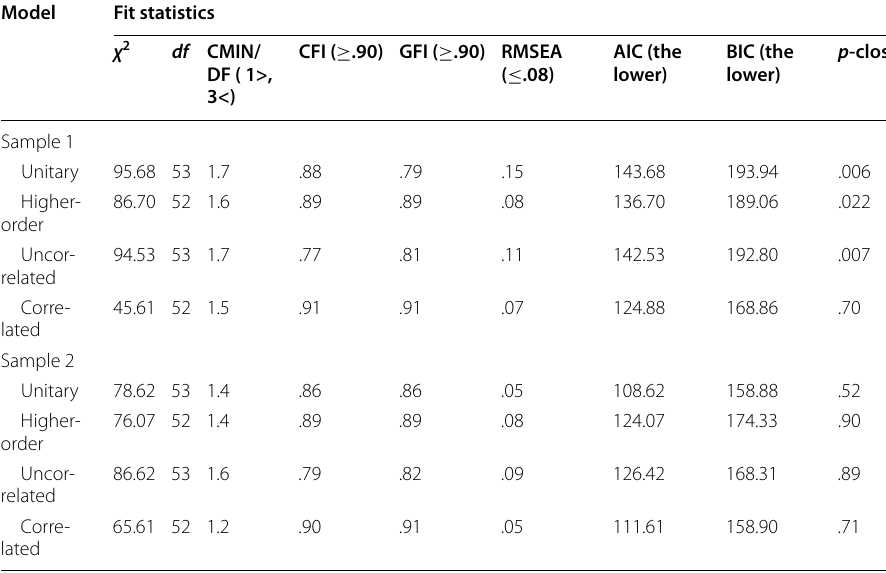
Table 3 Goodness-of-fit indices of the four hypothesized